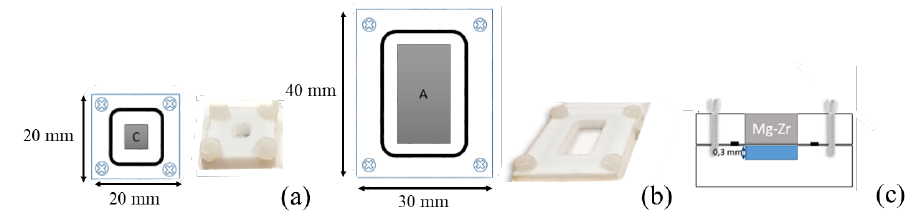
Figure 1. Description of the reactors used for the MgZr substrates corrosion in poral solutions extracted from geopolymers. ( a ) Reactor for samples analyzed using microscopies (5 × 5 × 3 mm 3 ), ( b ) reactor for samples analyzed by GI-XRD (20 × 10 × 3 mm 3 ) and ( c ) cross section schematization of the reactor.